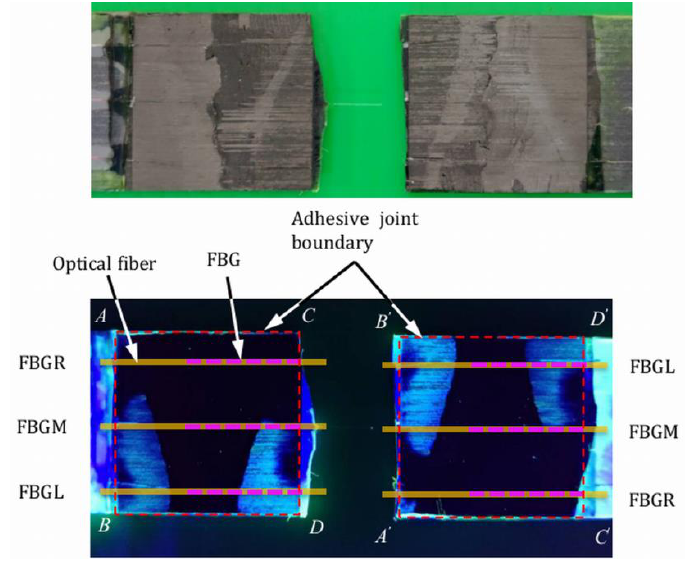
Figure 13. Fatigue-fractured adhesive joint observed under visible light ( top ) and UV light ( bottom ) after fluorescent penetrant treatment.